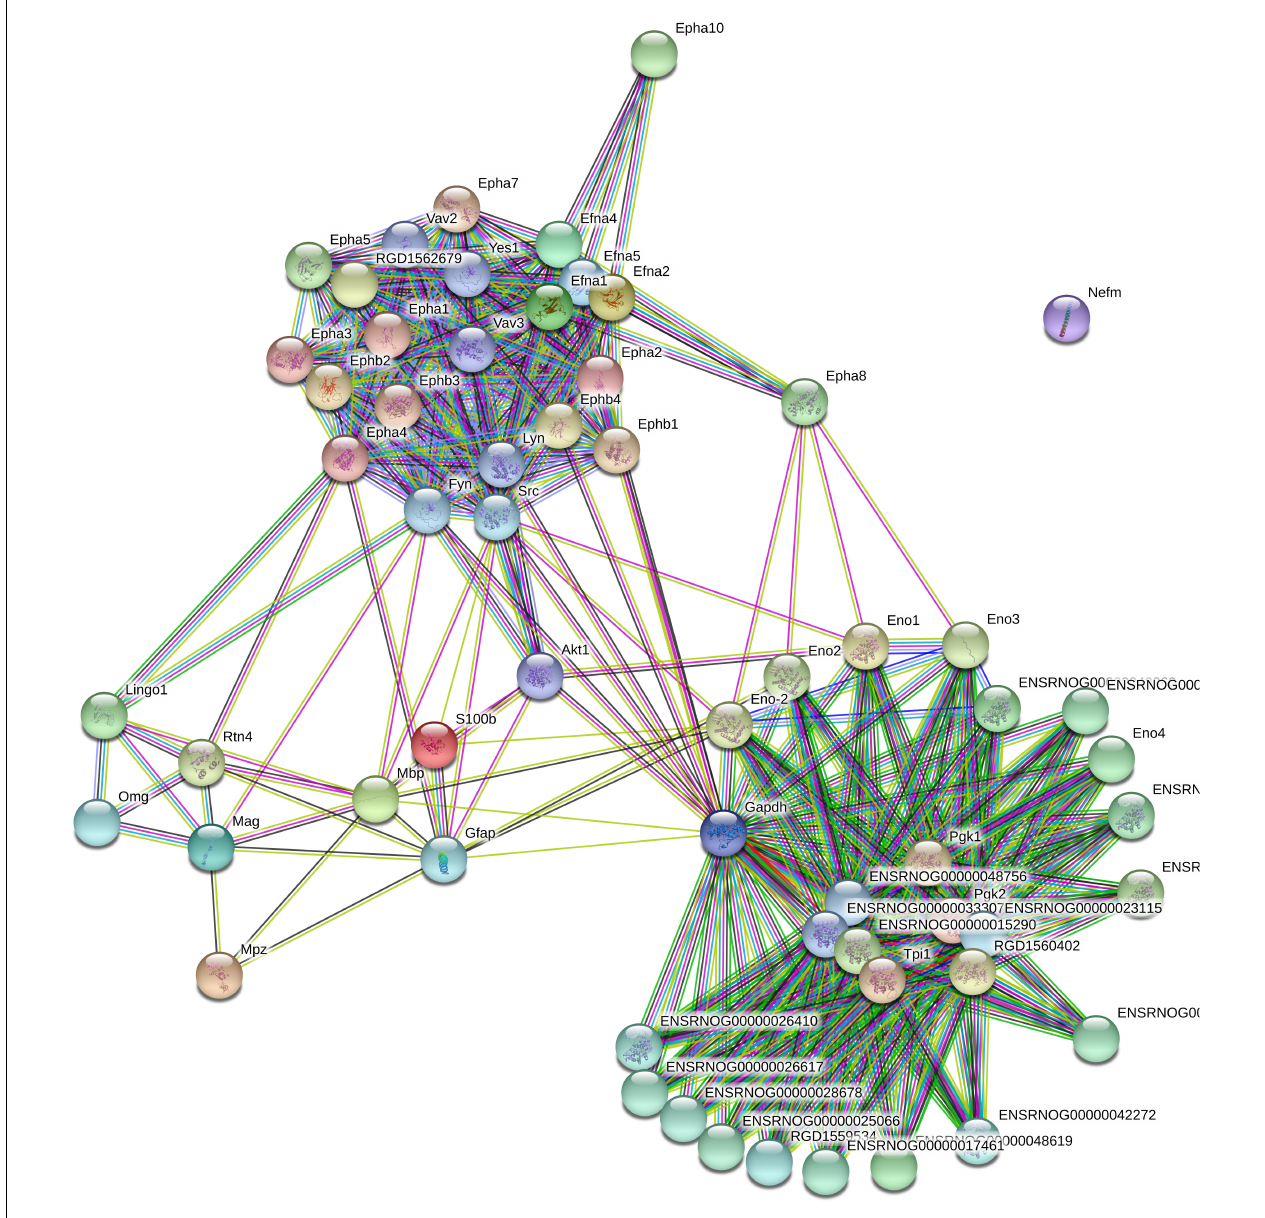
FIGURE 1 | Grown network dataset from neuron-glia interaction with more than 50 interactions (https://string-db.org/).